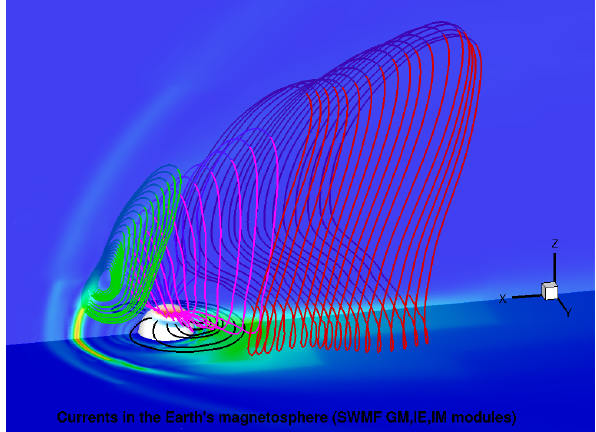
Figure 6. Current lines obtained by global magnetospheric model- ing with the SWMF. The view is from near dusk with the Sun to the left, the inner white sphere is has a 2.5 R E radius, the color on the sphere shows field-aligned current intensity, and the background color shows total current density in the y = 0 and z = 0 planes. The colors of the lines represent different current systems: green is the Chapman–Ferraro magnetopause current, pink is the region 1 field- aligned current system, black is the region 2 and partial ring current system, and red is the tail